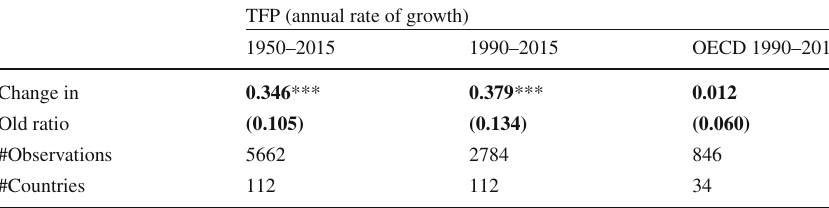
Table 4 Population ageing and Total Factor Productivity (TFP) TFP (annual rate of